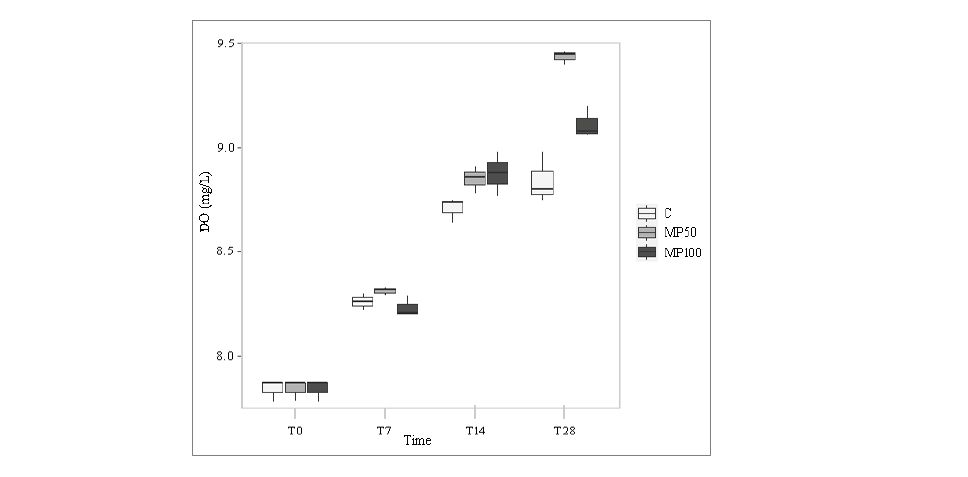
Figure 1. Dissolved oxygen (DO) in the control (C) and microplastic treatments (MP50 and MP100) at different exposure times (T0, T7, T14, and T28).